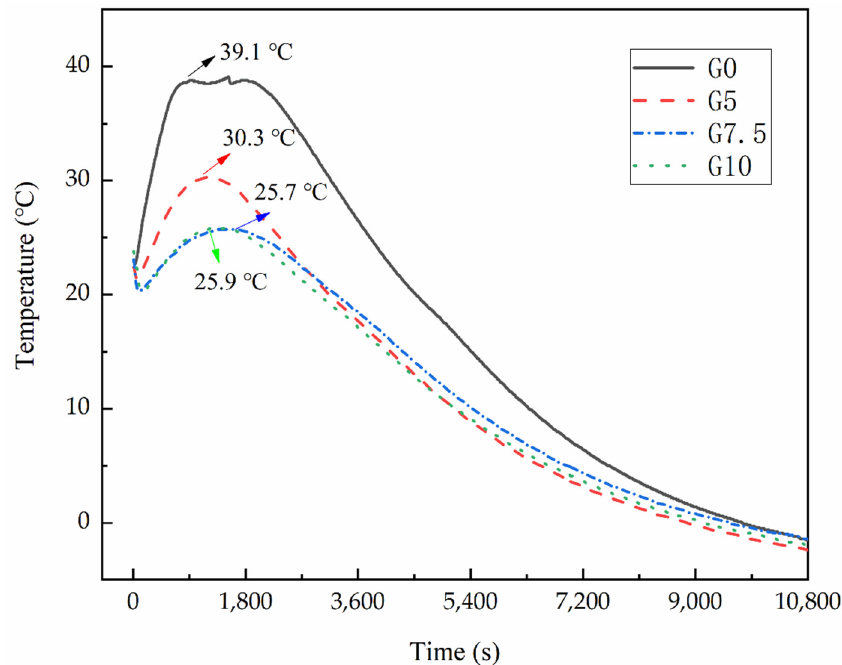
Figure 7. Effect of different water glass contents’ MgO on hydration temperature of MPC at − 5 °C.